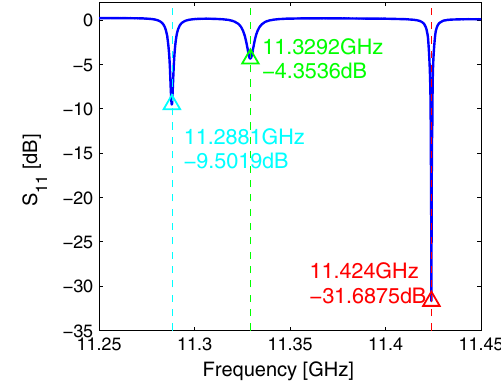
FIG. 8. Lower-power rf measurement result of THU-CHK-#3 after tuning.